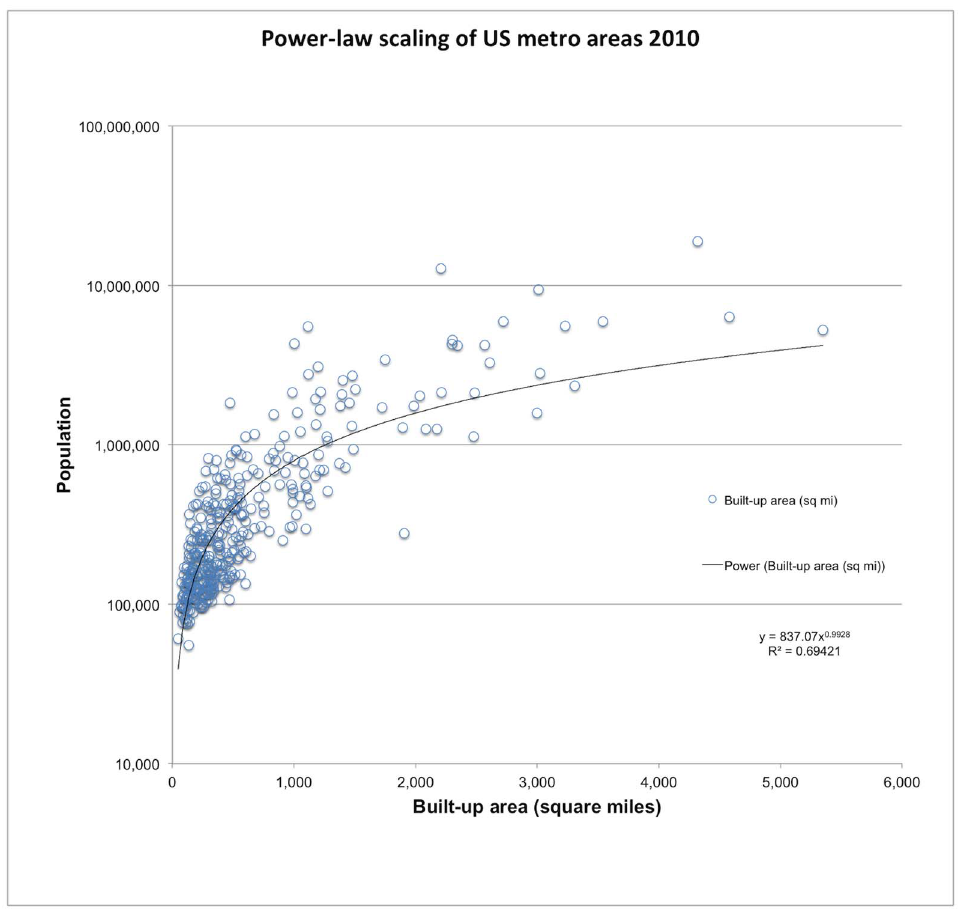
Figure 8. The population of US metropolitan areas follows a power law-scaling to the developed ‘‘footprint’’, which includes built- up land uses except for urban parks and golf courses. Computing the ratio of the raw population to the footprint (scale) adjusted population provides a relative measure of land use efficiency for metropolitan areas.